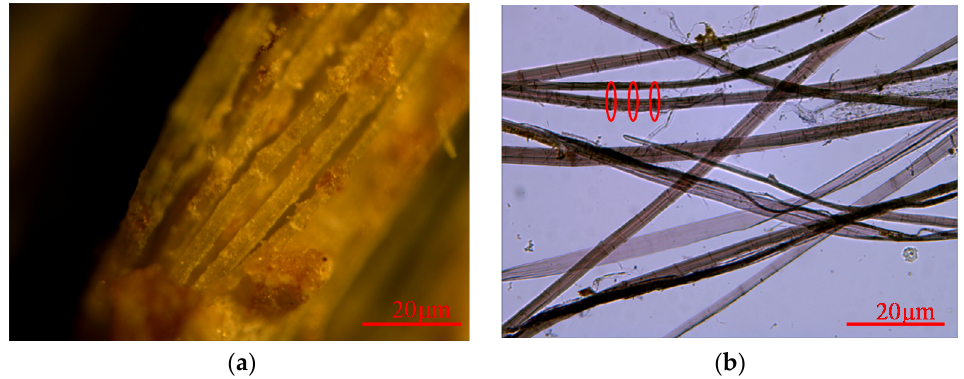
Figure 6. ( a ) Photo of untreated ramie fibers under a polarizing microscope at 20×; ( b ) photo of ramie fibers under a polarizing microscope at 20× and treated with Herzberg stain.